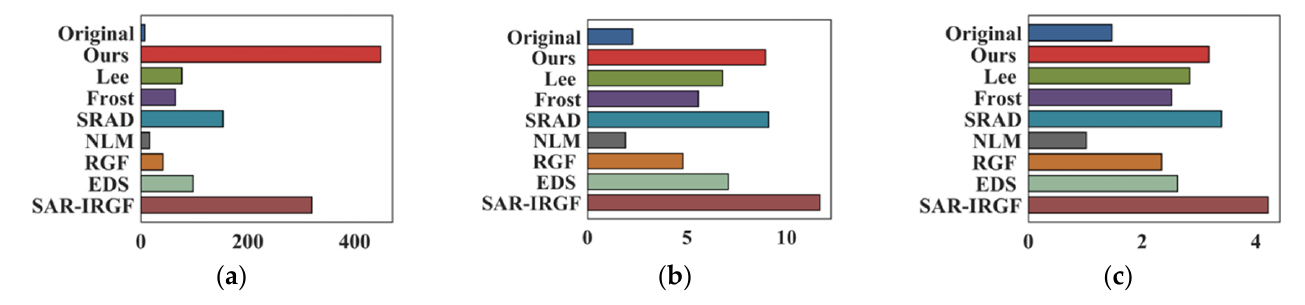
Figure 18. ENL results for the speckle suppression on Ku-band SAR image: ( a – c ) are the ENL results corresponding to subregion 1 to 3, respectively.